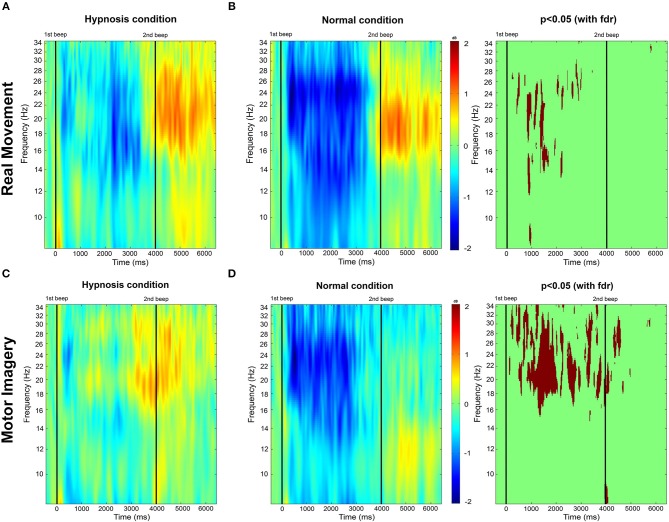
(A,B) Time-frequency grand average analysis corresponding to an event-related spectral perturbation (ERSP) for Session 1 (Normal condition) and Session 2 (Hypnotic condition) for a real movement for electrode C3. (C,D) Time-frequency grand average analysis (ERSP) for Session 1 (Normal condition) and Session 2 (Hypnotic condition) for a motor imagery for electrode C3. Red corresponds to a strong ERS and blue to a strong ERD. Significant differences (p < 0.05) with a False Discovery Rate (FDR) correction are shown in the right part of the figure.